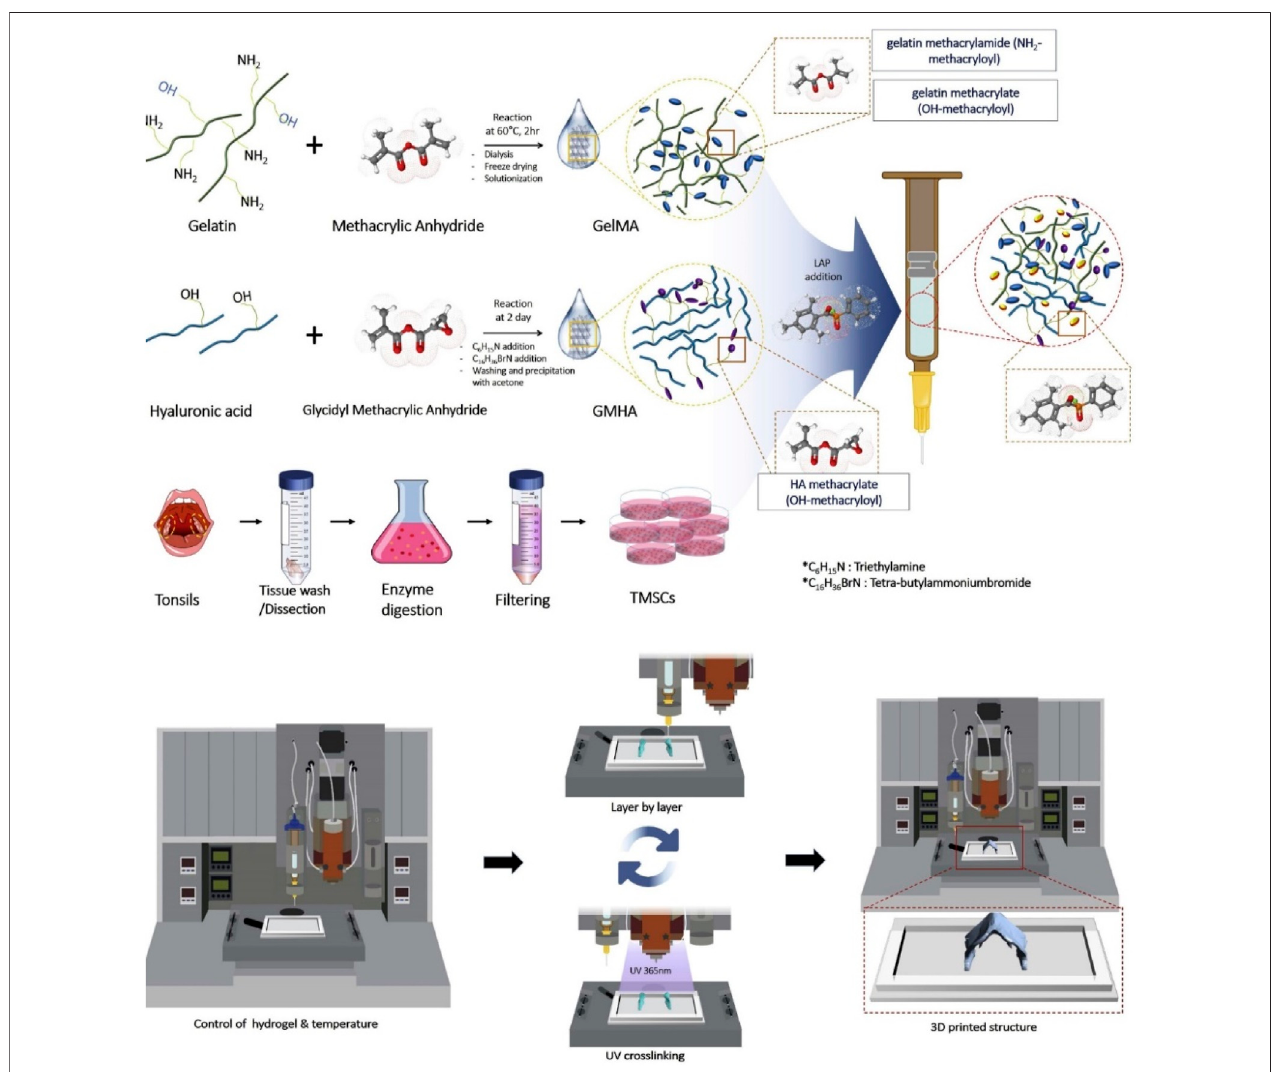
FIGURE 3 | Scheme of the preparation of GelMA/GMHA bio-ink using the 3D bioprinting technique. Reproduced from Lee et al., (2020) with permission from Copyright 2020 Elsevier.